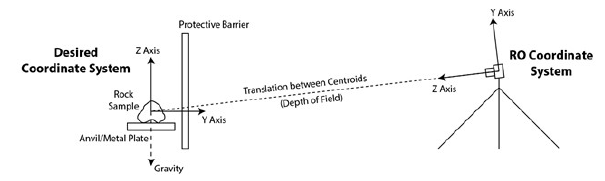
Figure 5. Coordinate system